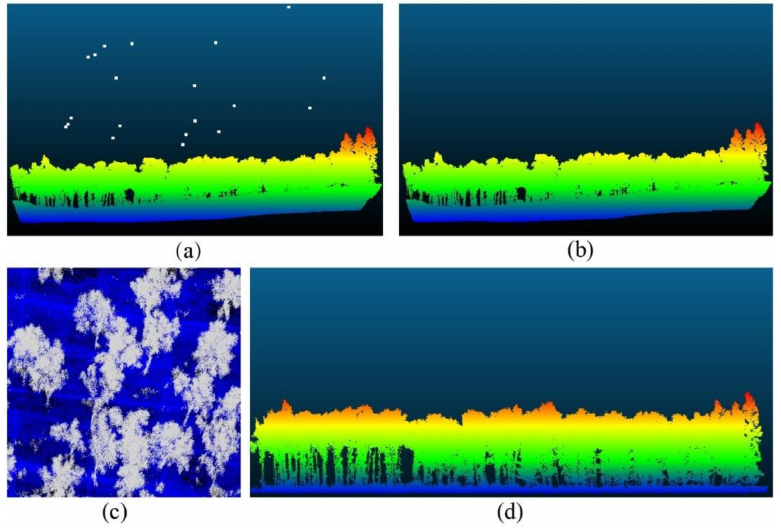
Figure 4. ( a ) Point cloud original data; ( b ) Data after removing noise points; ( c ) Ground point separation; ( d ) After normalization of point cloud